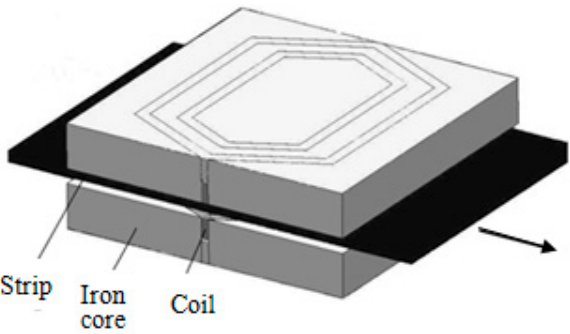
Figure 2. Model of transverse flux induction heating (TFIH) equipment.